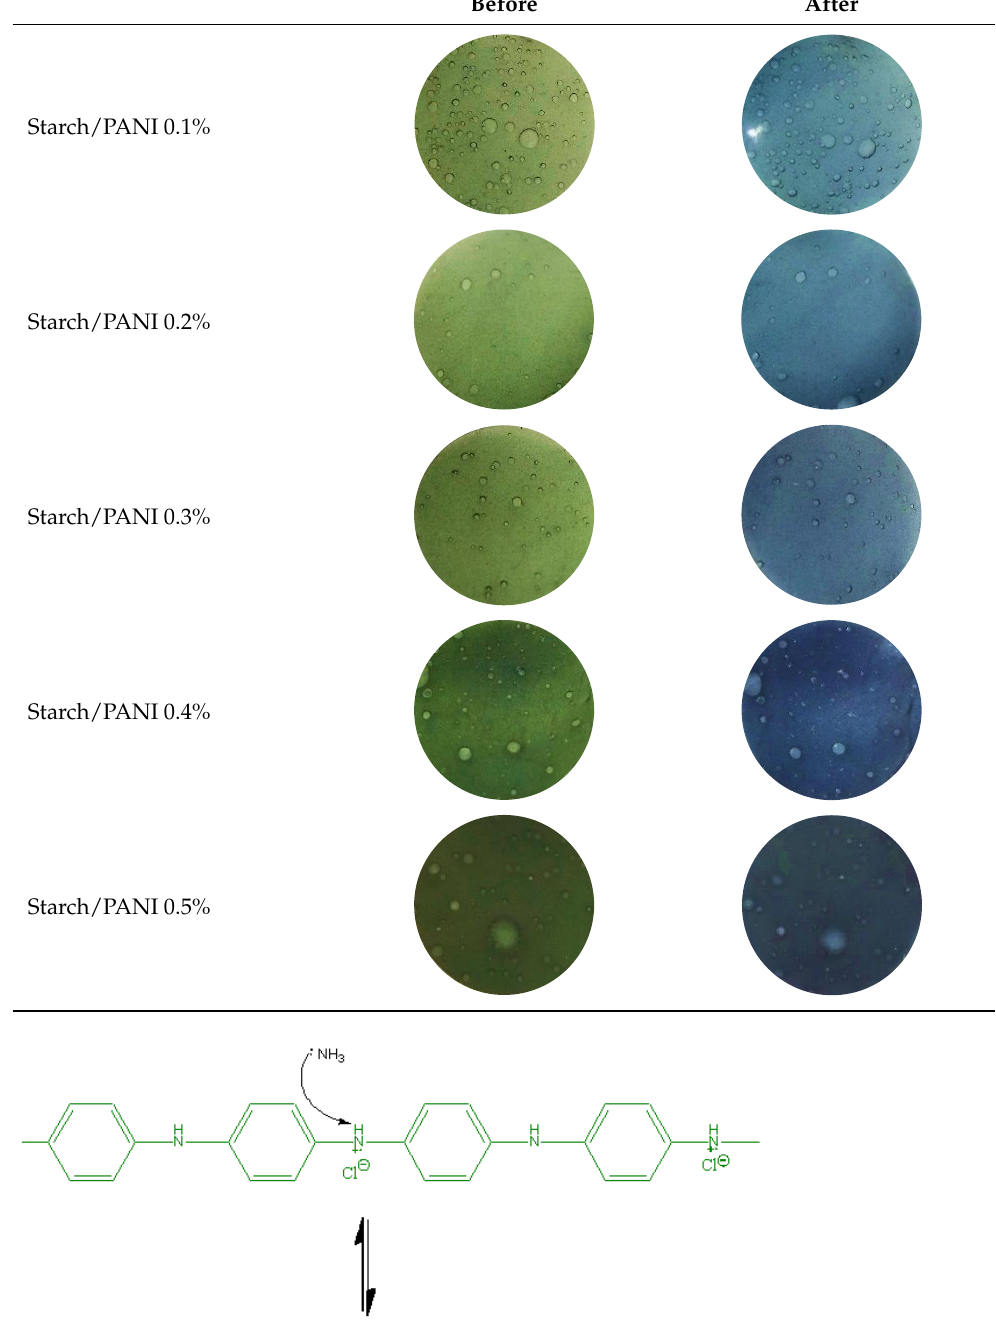
Starch/PANI 0.1%